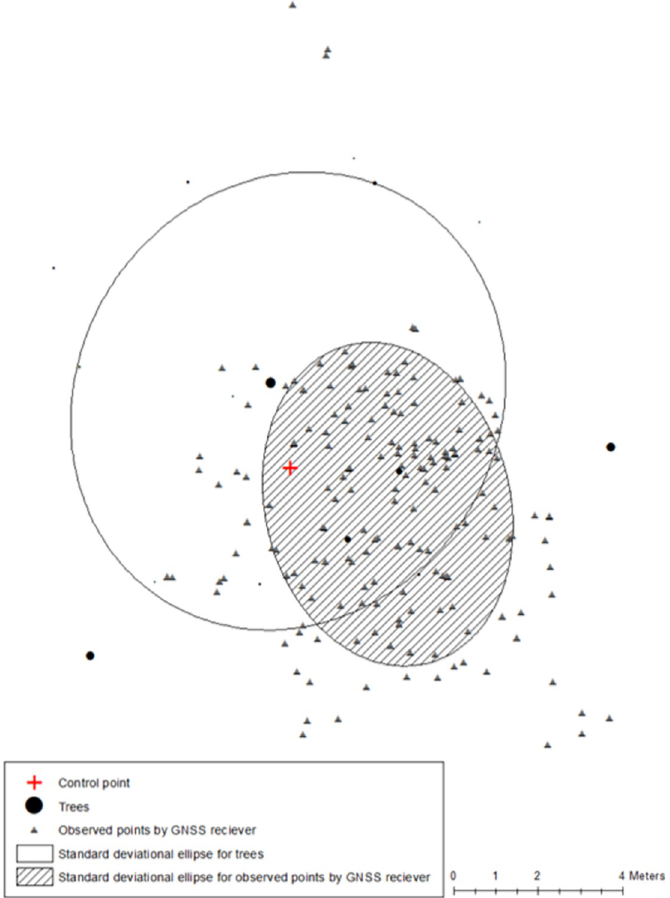
Fig 2. An example of standard deviational ellipses. Each standard deviational ellipse was determined based on the location of nearby trees and the observed points by GNSS receiver.